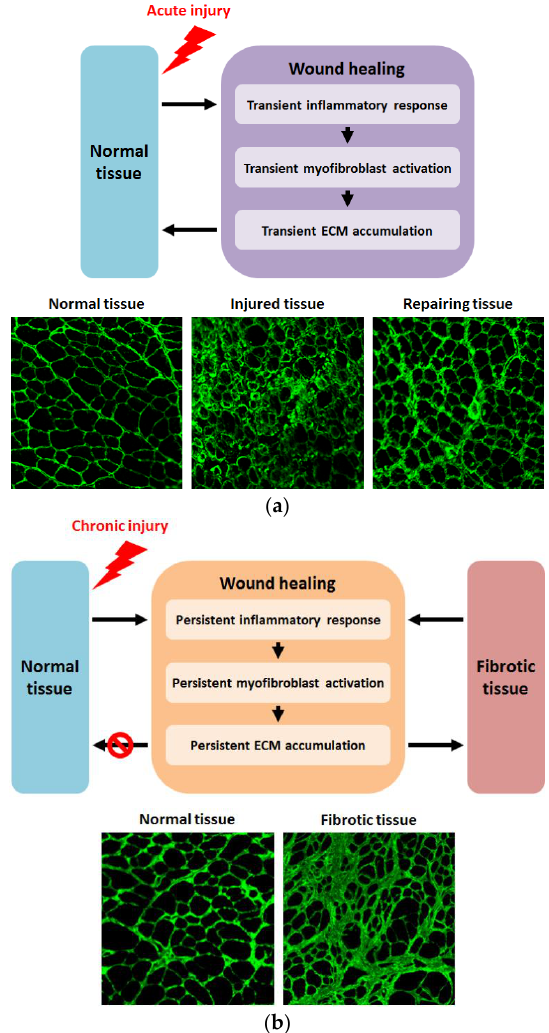
Figure 1. Outlines of normal wound healing following acute injury and fibrogenesis as a result of chronic injury: ( a ) Acute injury to normal tissue results in transient inflammation, leading to activation and proliferation of myofibroblasts, resulting in temporary ECM material accumulation, with restoration of ECM homeostasis once repair is complete and, ultimately, normalization of tissue architecture. Lower panels show cross-sections of normal ( left ), injured ( center ), and repairing ( right ) tibialis anterior muscle of 24-month-old wild-type mice immunostained for collagen VI at 200 × magnification. Centre panel shows injured muscle 2 days after injury induced by injection with barium chloride, while right panel shows tissue repair 14 days post-injection, with muscle architecture beginning to normalize; ( b ) Chronic injury results in persistent inflammation, leading to recurrent myofibroblast activation and proliferation, which results in persistent and excessive ECM deposition and the development of fibrotic tissue. Lower panels show cross-sections at 200 × magnification of the diaphragm of 9-month-old wild-type ( left ) and dystrophic mdx ( right ) mice immunostained for collagen VI. Wild-type muscle shows normal tissue structure, while mdx muscle displays fibrotic architecture with excessive and disruptive ECM